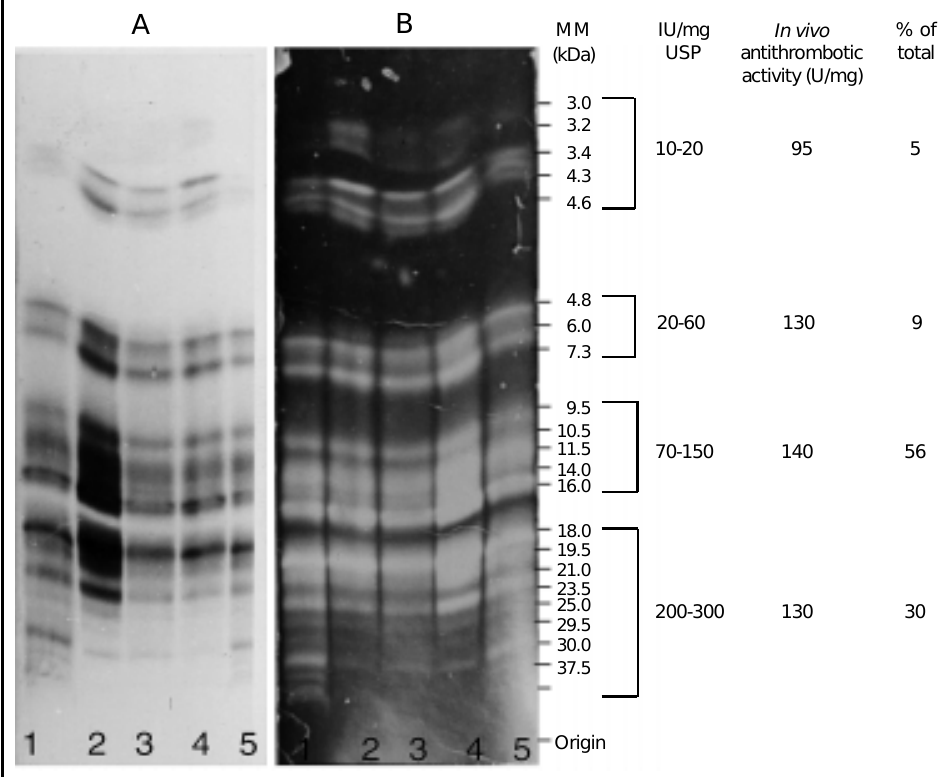
Figure 4. Anticoagulant and anti- thrombotic activities of heparin fractions obtained by electrofo- cusing. A , Toluidine blue stain- ing. B , Precipitated complexes of ampholine-heparin fractions photographed against a black background. Lanes 1 to 5 , Phar- maceutical companies (1: Riker; 2: Roche; 3: Wilson; 4: Lederle; 5, Upjohn). USP, United States Pharmacopea anticoagulant as- say; MM, molecular